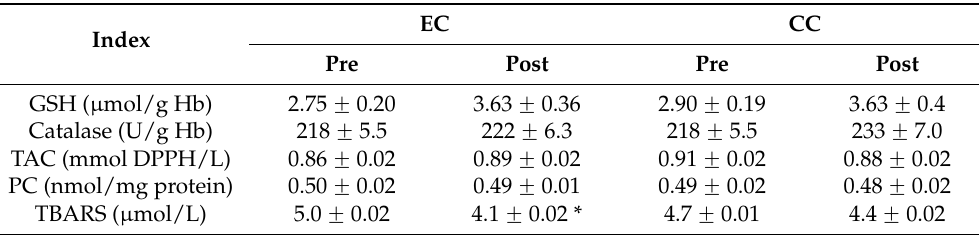
Table 5. Indices of redox status following polyphenol-enriched (EC) and plain (CC) yogurt consumption (Mean ˘